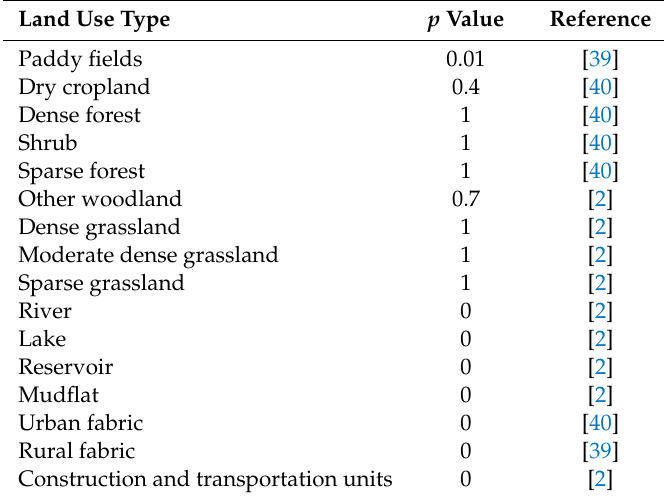
Table 2. The P factor values of di ff erent land use types on the